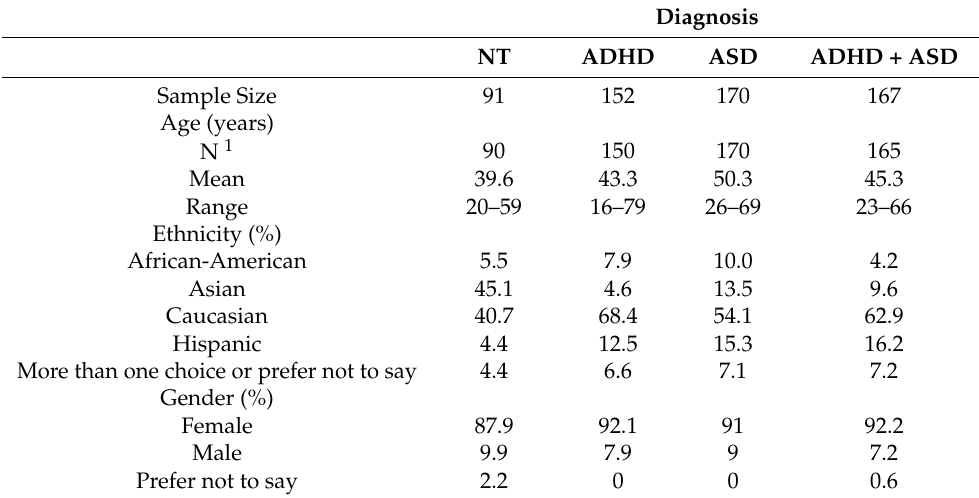
Table 1. Demographic characteristics of caregivers.